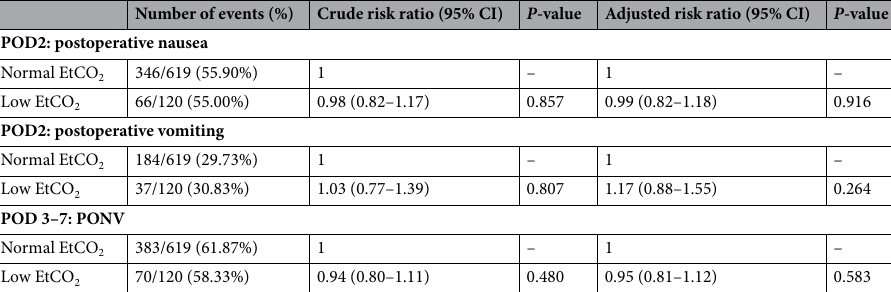
Crude difference in PLOS (95% Median (IQR) P value CI) P-value